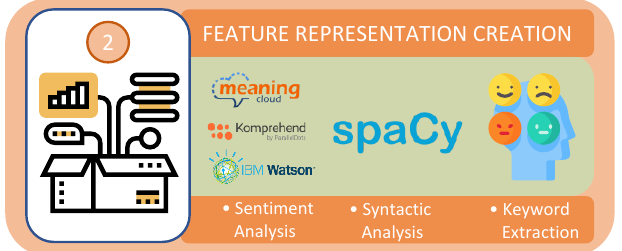
Figure 3. The creation of our feature representation proposal consisted of using three NLP APIs (Parallel Dots [80], Meaning Cloud [81], IBM NLU [82]) to perform sentiment analysis and the Python spaCy library [83] for extracting the syntactic features and the keywords of the tweets.